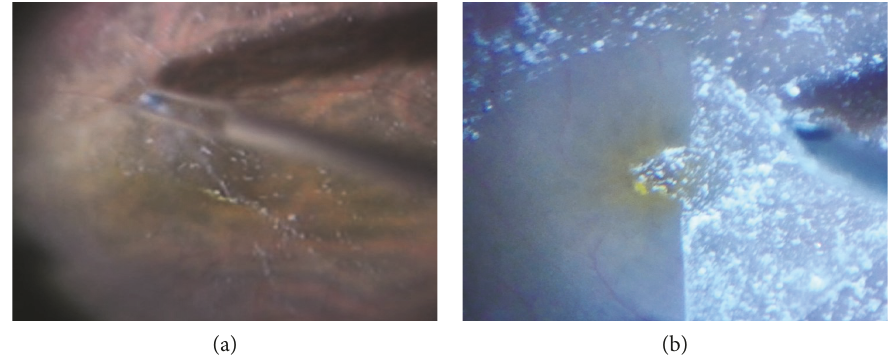
Figure 4: Triamcinolone acetonide-assisted internal limiting membrane (ILM) peeling in vitreoretinal surgery. (a) The border of the macular hole cannot be seen in the conventional video image. (b) The ILM with triamcinolone and the border of the macular hole can be seen in the 4K image.